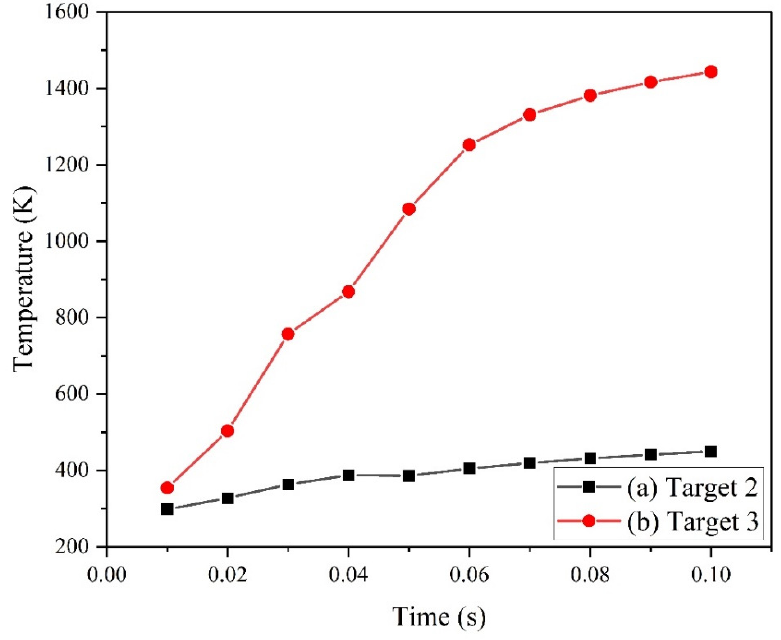
Figure 12. Simulation temperature rise curves of two targets in t = 0.1 s.